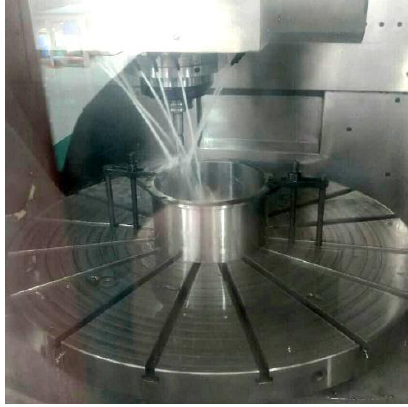
Figure 22. Machining process.